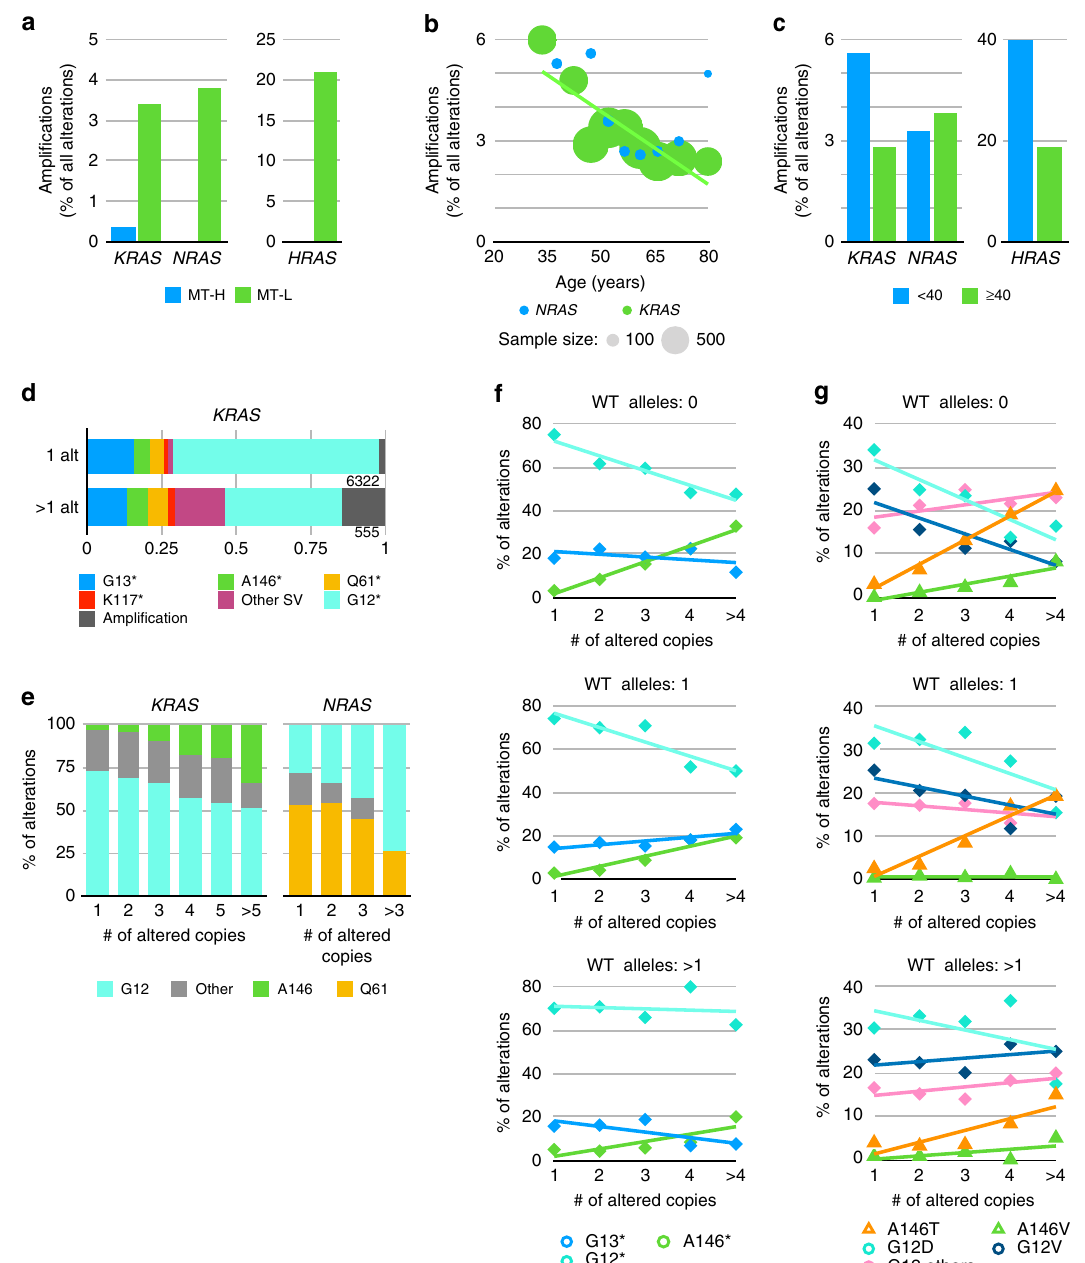
Fig. 5 Copy number variation (CNV) and missense pro fi le. a Frequency of ampli fi cation of the wt allele of KRAS , NRAS , or HRAS in the analyzed colorectal cancer (CRC) cohort, based on MSI-H/low TMB (MT-L) or MSI-H/high TMB (MT-H) status. b , c Frequency of ampli fi cation of the wt allele of KRAS or NRAS in MT-L CRC tumors, based on age as a continuous variable ( b ) or dichotomized as <40 or ≥ 40 ( c ). d . Frequency of ampli fi cation of mutated allele of KRAS is elevated in CRC tumors carrying one or more alteration (alt). *Cumulative observed missense changes. e Frequency of missense mutations in indicated codons as a factor of copy number in the mutated allele of KRAS or NRAS . f Frequency of missense mutations in indicated codons as a factor of increased copy number in the mutated allele of KRAS , in the context of indicated CNV in the wt allele of KRAS . *Cumulative observed missense changes. g Frequency of speci fi c missense mutations in codons G12 and A146 as a factor of increased copy number in the mutated allele of KRAS , in the context of indicated CNV in the wt allele of KRAS . G12 others refers to combined rare missense mutations in G12 (e.g.,